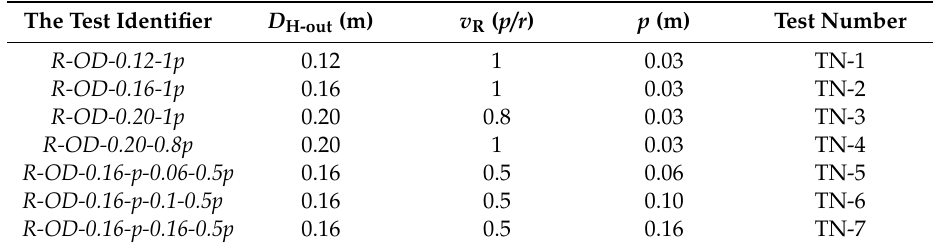
Table 3. Experimental program and key